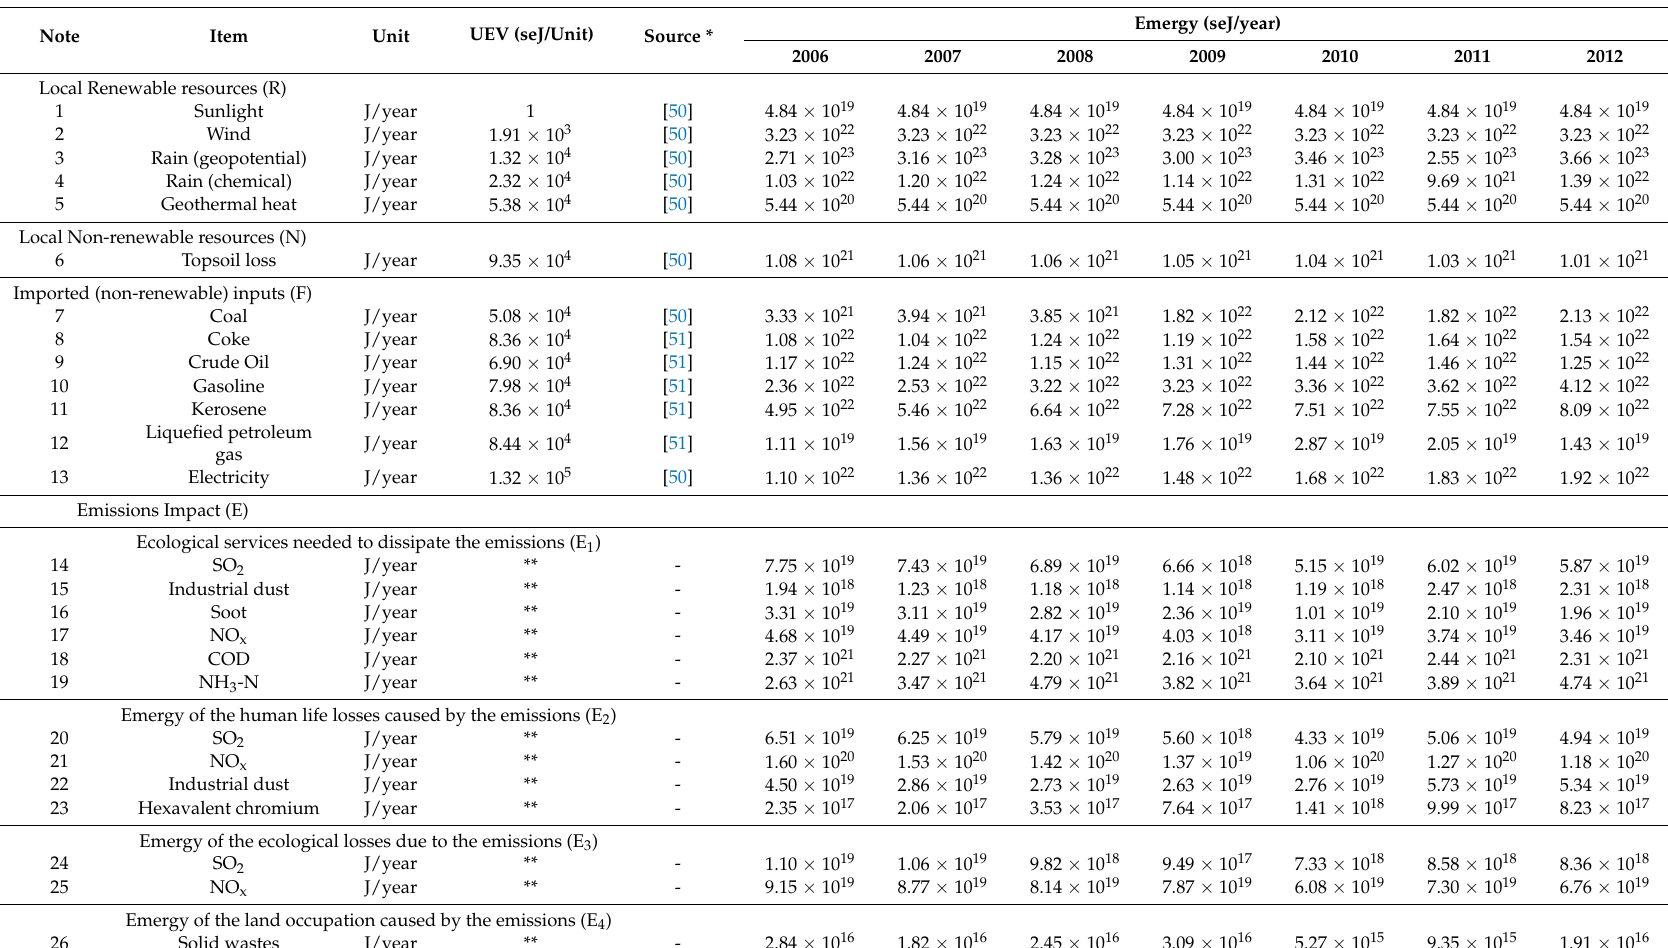
Table 4. Emergy synthesis for the regional ecosystem of Wuhan from 2006 to